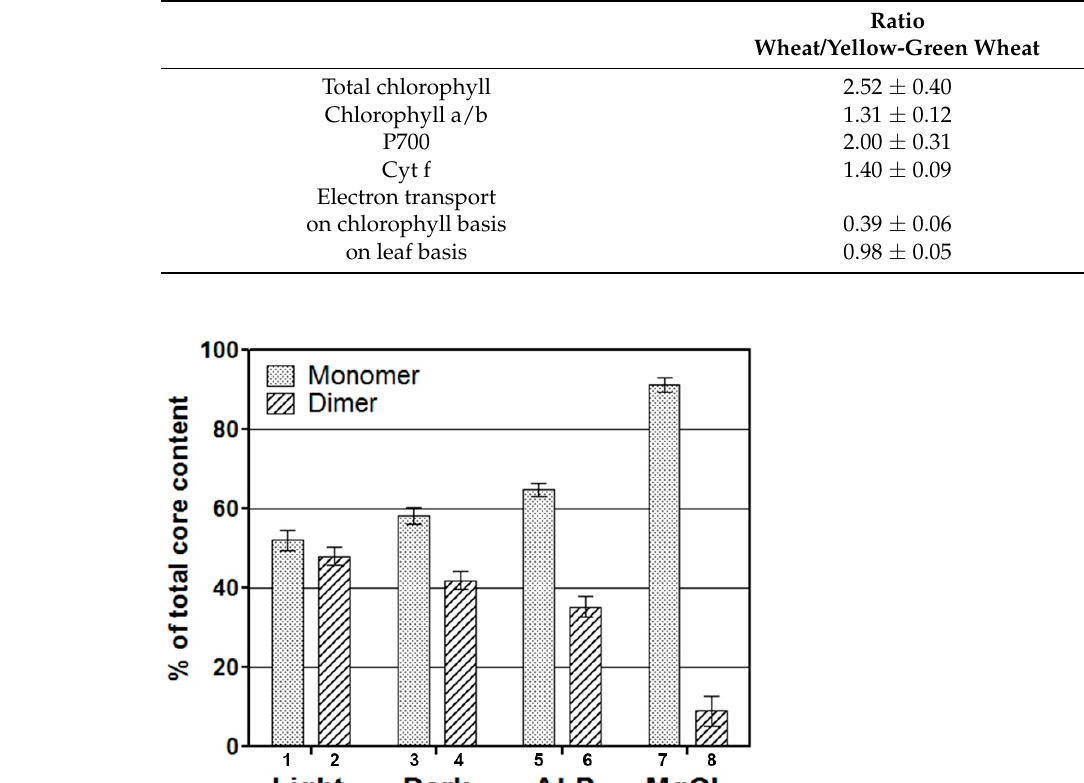
Table 1. Photosynthetic characteristics of wheat and yellow-green wheat as a ratio between the wheat/yellow-green wheat are shown.